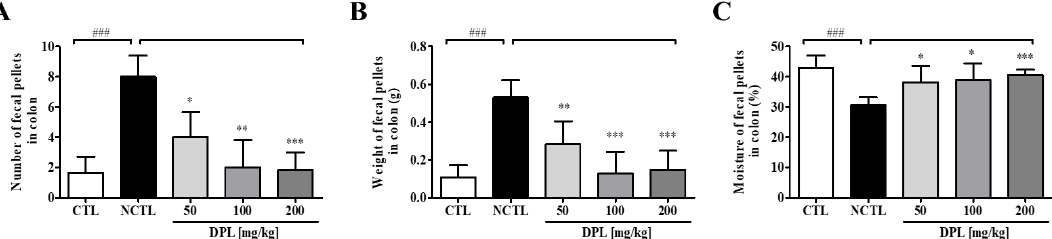
Figure 4. The preventive effects of D. morbiferus H. Lév. leaf extract (DPL) on low-fiber diet-induced constipation. The differences in total number ( A ), weight ( B ), and water content ( C ) of stools contained in the intestines at 12 days induced by pretreatment with DPL three days before constipation induced by the low-fiber diet are shown. ### Significant difference at p < 0.001 compared with the control group (CTL). * Significant difference at p < 0.05, ** at p < 0.01 and *** at p < 0.001 compared with the low-fiber diet-induced constipation group (negative control group; NCTL).